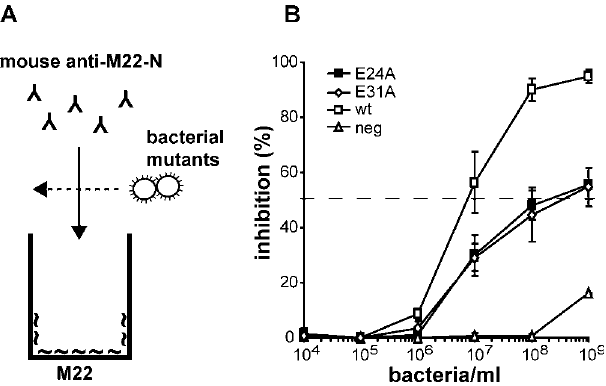
Figure 6. Single Amino Acid Changes Not Affecting C4BP Binding Cause Major Antigenic Changes in the HVR of M22 (A) Schematic representation of an inhibition test used to analyze the antigenic properties of mutant M22 proteins expressed on the surface of S. pyogenes. The test was based on the binding of mouse anti–M22-N to pure M22 protein immobilized in microtiter wells. This binding was inhibited with whole S. pyogenes bacteria expressing mutant M22 proteins. (B) Ability of S. pyogenes strains expressing the M22 mutants E24A and E31A to cause inhibition. The positive control expressed the wild-type M22 protein and the negative control lacked M protein. As compared to the positive control, 50% inhibition (dashed line) required ; 30-fold more bacteria expressing either of the mutant proteins. Results based on three separate experiments with duplicate samples, presented as means 6 SD. DOI: